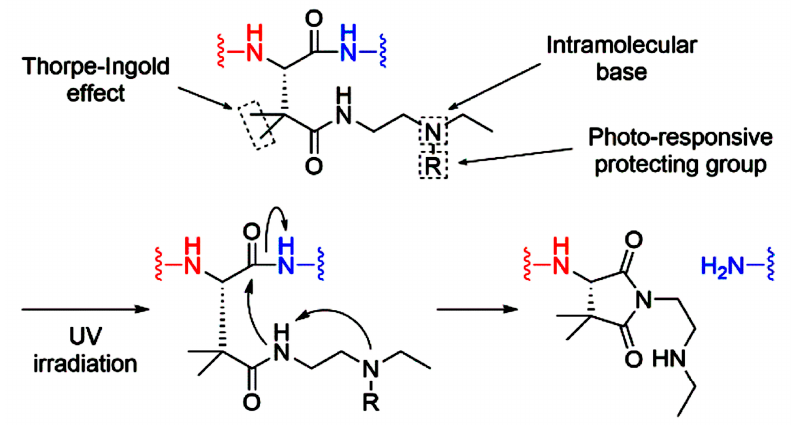
Figure 11. Photoinduced peptide bond cleavage inspired by natural protein splicing. Reprinted with permission from [50]. Copyright 2016 American Chemical Society.